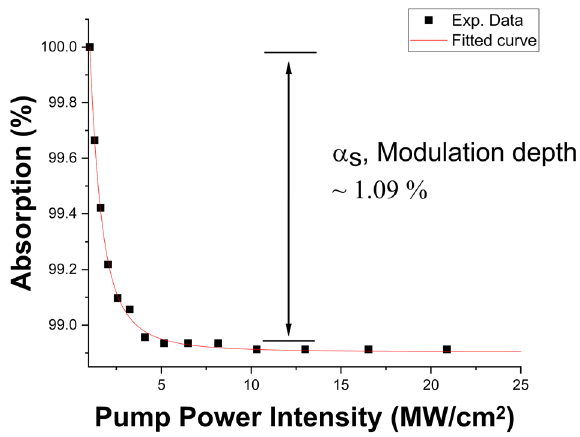
Figure 7. The nonlinear absorption test of the side polished fiber Ta 2